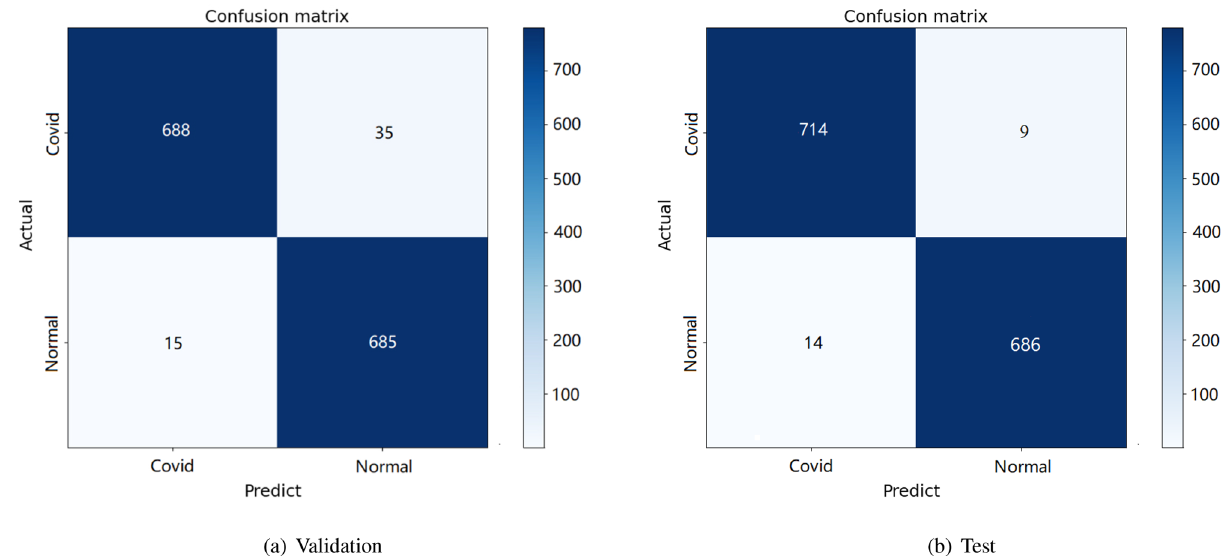
Figure 5. Confusion matrix for VGG16 on X-ray dataset: